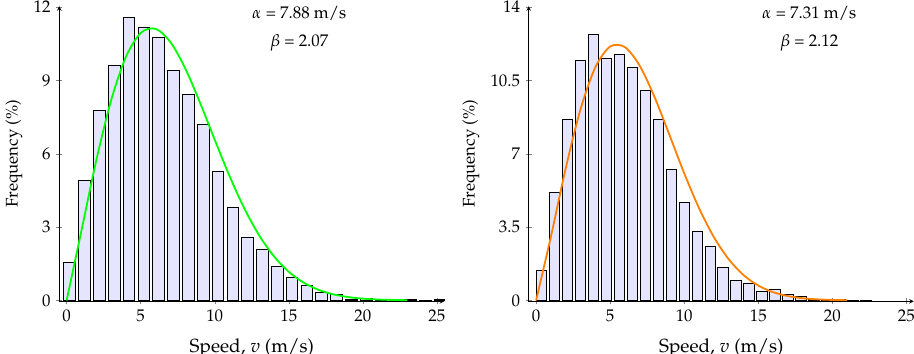
Figure 9. Frequency distribution for Cookhouse (left) and Stormberg (right).